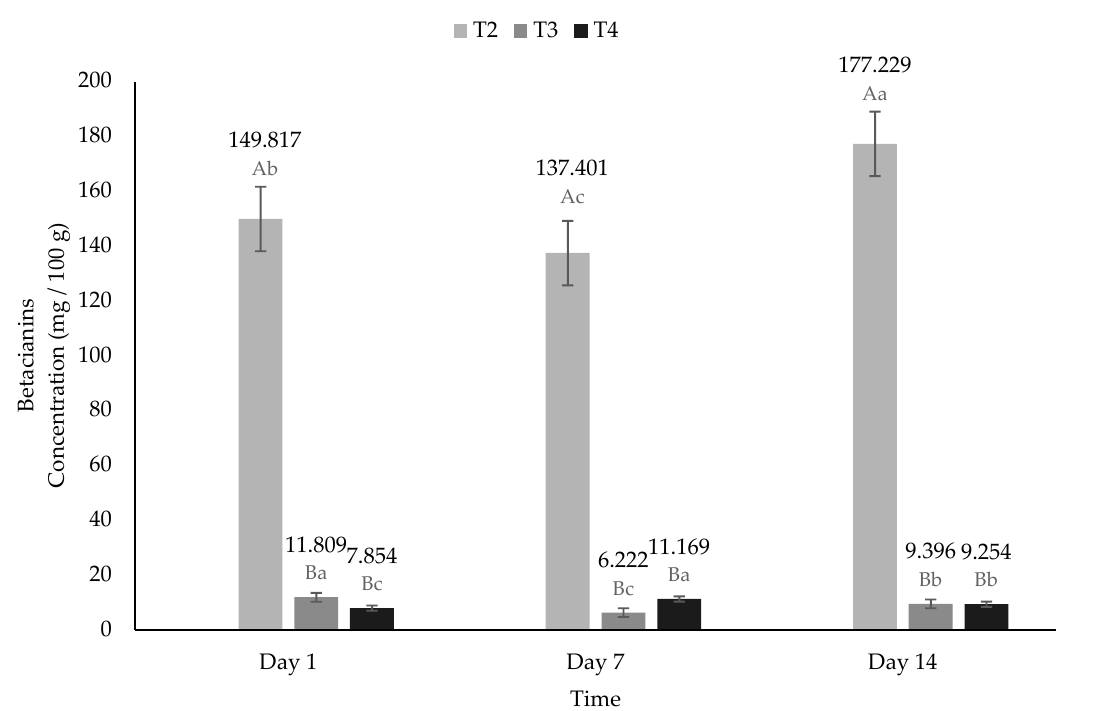
Figure 7. Betacyanins content of yogurt added with beet extract. T2 = Y added with beet juice, T3 = Y added with extract encapsulated with Maltodextrin, and T4 = Y added with extract encapsulated with Inulin. A,B Values with different superscript indicate significant statistical difference between treatments ( p < 0.05). a,b,c Values with a different superscript indicate significant statistical difference over time ( p < 0.05).